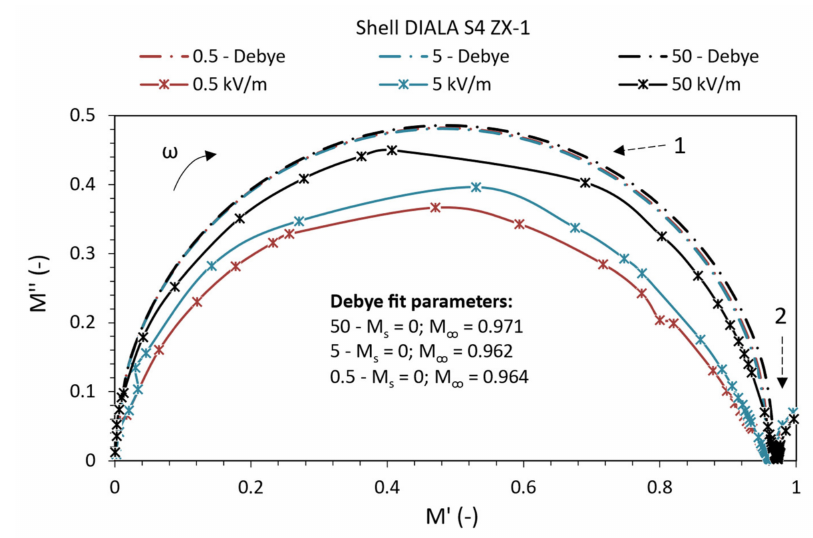
Figure 6. Cole-Cole diagram of a complex electric modulus M* of SD oil.